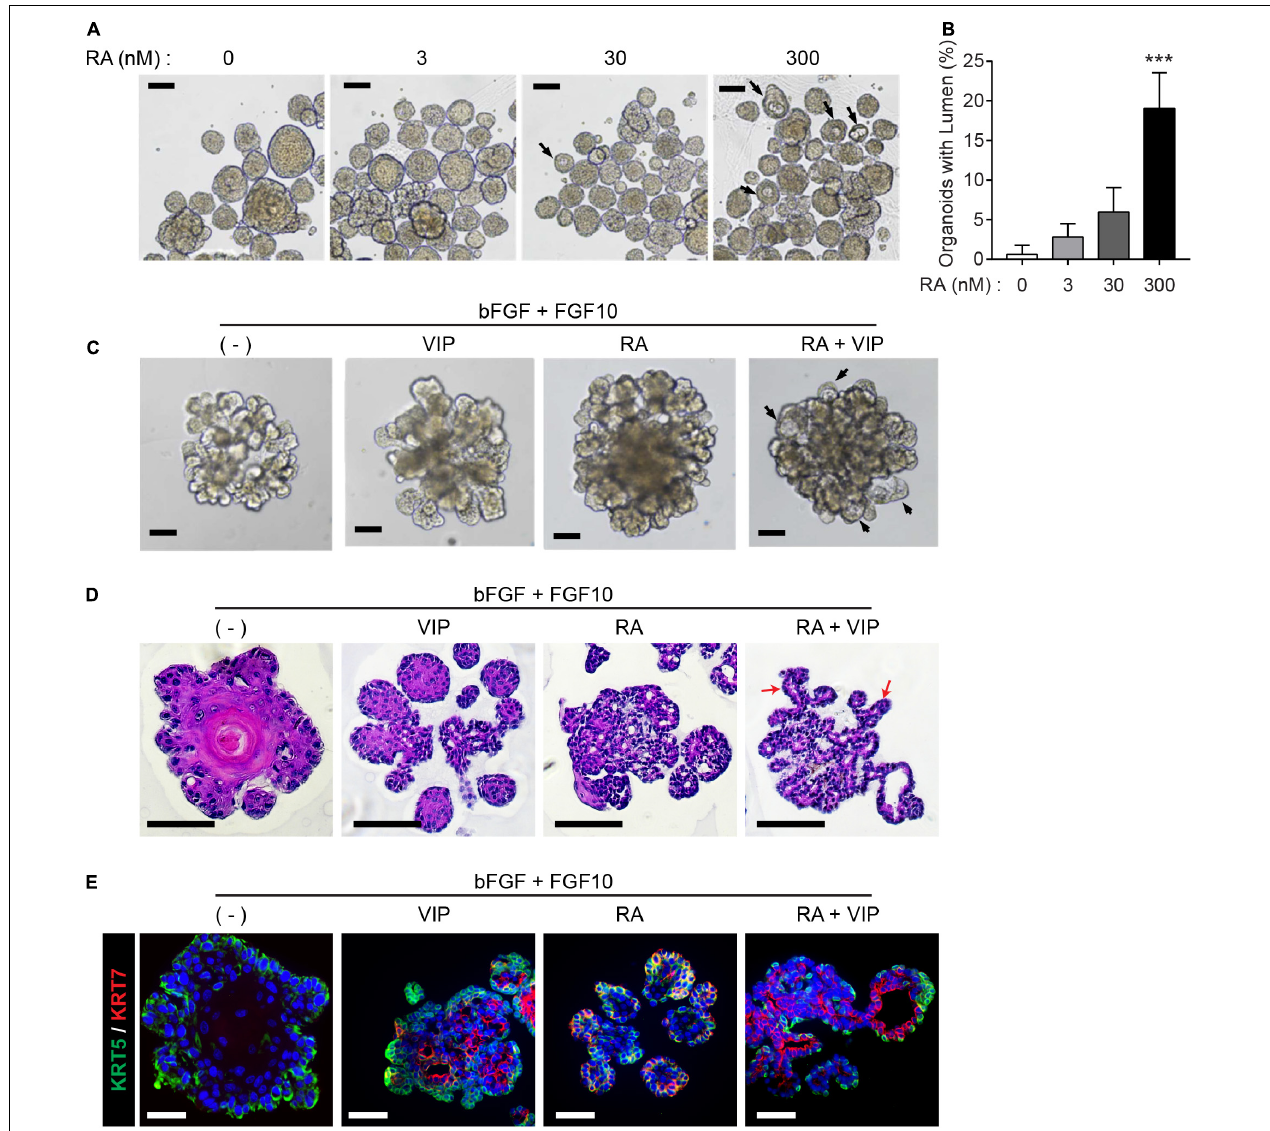
FIGURE 2 | Retinoic acid promotes lumen formation in SMG organoids. (A) SMG organoids were cultured with different doses of RA and treated with 200 nM VIP on day 4. Microscopic images of lumen formation were obtained on day 6. Scale bars indicate 100 µ m. (B) The proportion of organoids containing internal lumen were calculated, followed by statistical analysis ( n = 3). Results are expressed as the mean ± SD. *** p < 0.001. (C–E) SMG organoids were cultured with or without RA in combination with 1 nM bFGF and 5 nM FGF10 throughout the culturing period. At day 9, organoids were either unstimulated or stimulated with VIP for 1 day. (C) Branching ducts were observed with brightfield microscopy. Black arrows indicate formation of lumens near end buds. Scale bars indicate 100 µ m. (D) Harvested organoid were subjected to H&E staining to observe lumen formation in branching ducts (red arrows). Scale bars indicate 100 µ m. (E) Organoids were subjected to immunofluorescence staining for KRT5 (green) and KRT7 (red). Scale bars indicate 50 µ m. Nuclei were counterstained with DAPI (blue). All experiments were performed three times